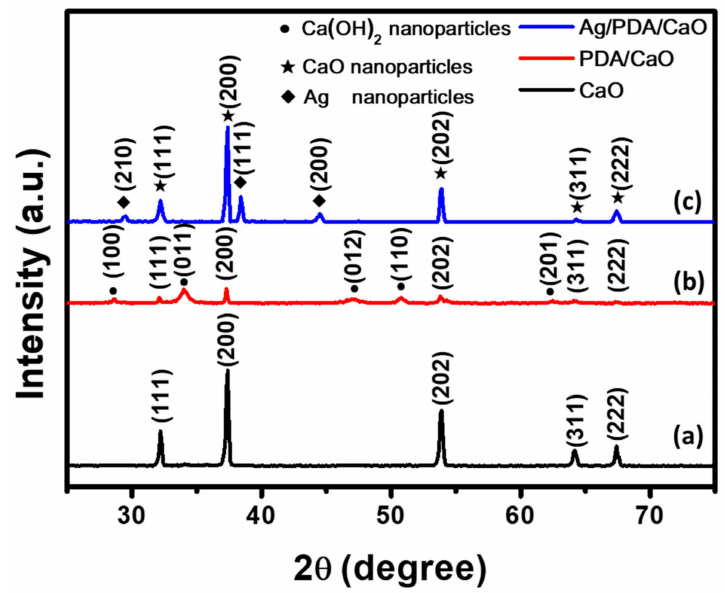
Figure 2. XRD patterns of synthesized ( a ) CaO NPs, ( b ) PDA/CaO and ( c ) Ag/PDA/CaO nanocomposites.